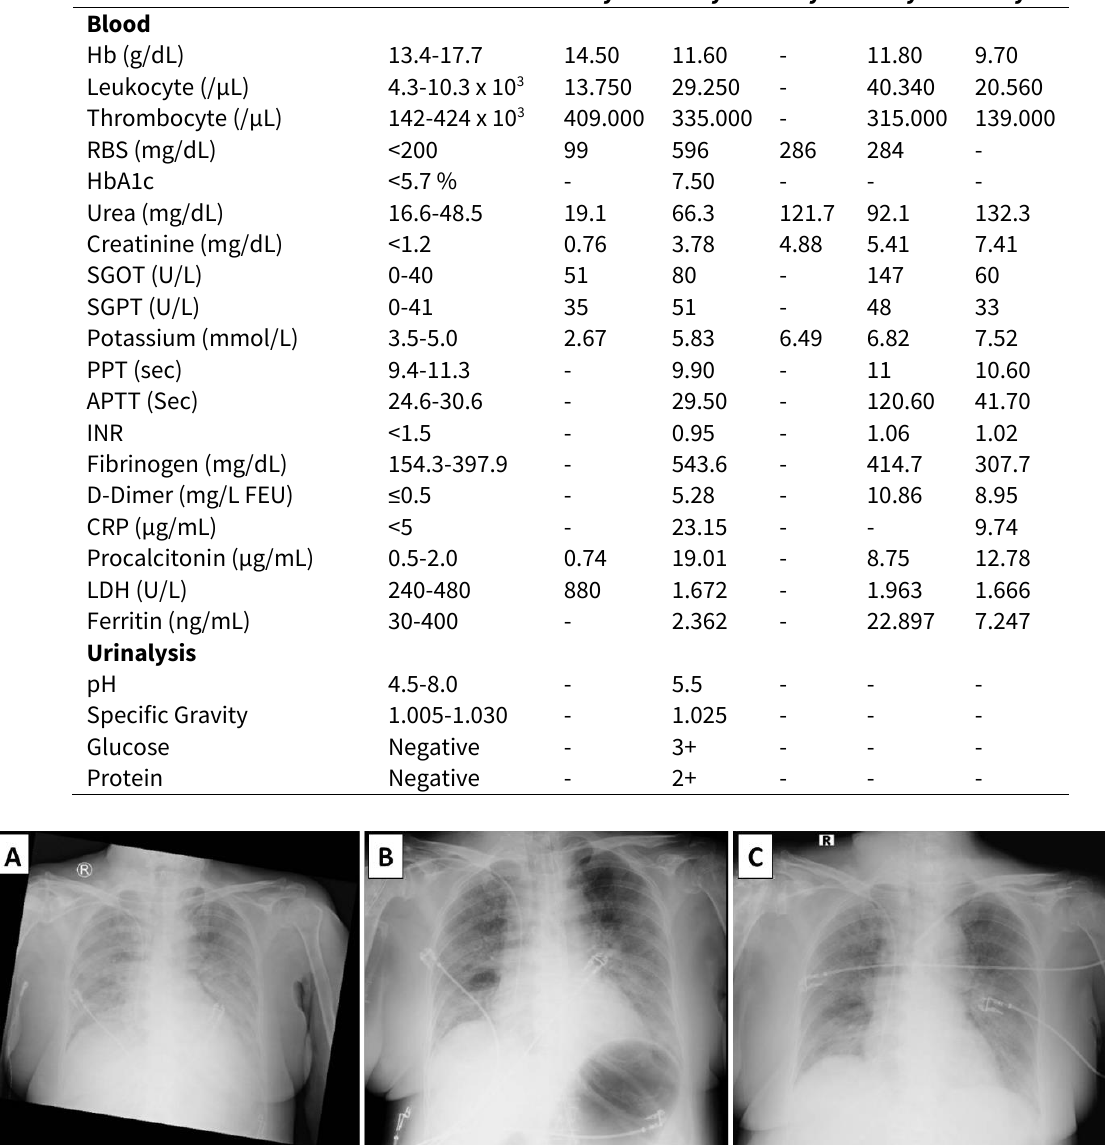
Figure 2. Development of 1st Patient Thorax